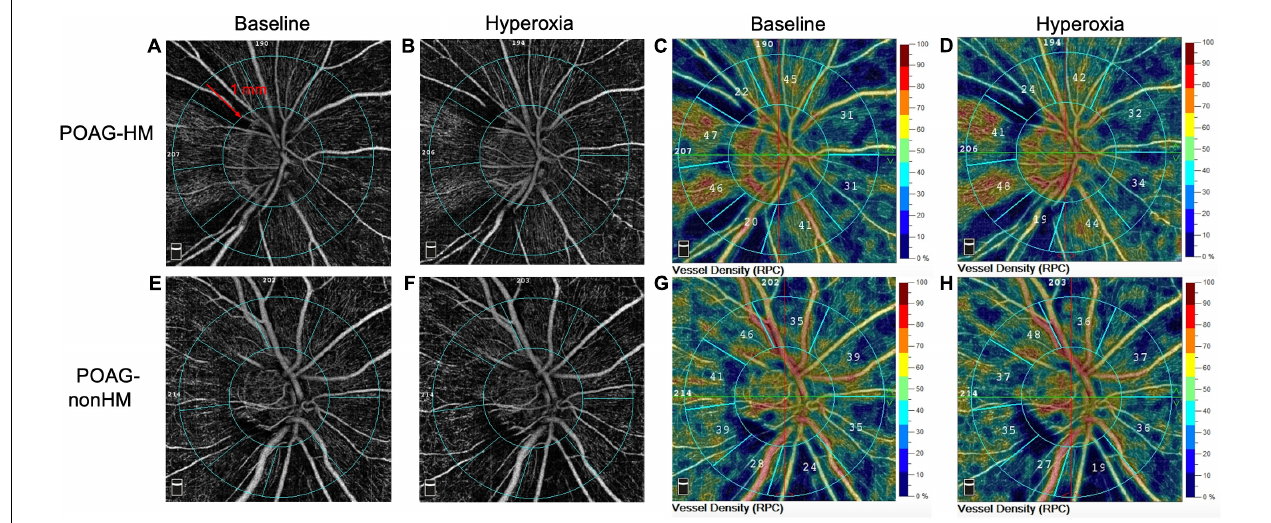
FIGURE 1 | Representative optical coherence tomography angiography (OCTA) images of the capillary vessel density around the optic disk in a primary open-angle glaucoma (POAG) eye with high myopia (POAG-HM) (A–D) and a POAG eye without high myopia (POAG-nonHM) (E–H) at baseline and during hyperoxia. The range of the peripapillary region of the 1-mm-wide annulus is defined in panel (A) . RPC, radial peripapillary capillary.